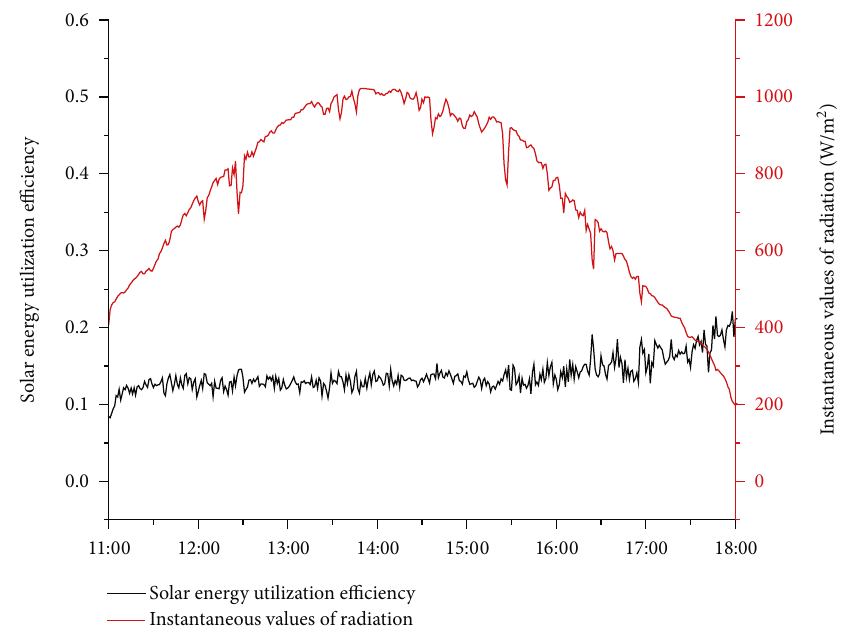
Figure 7: Fan runs at high